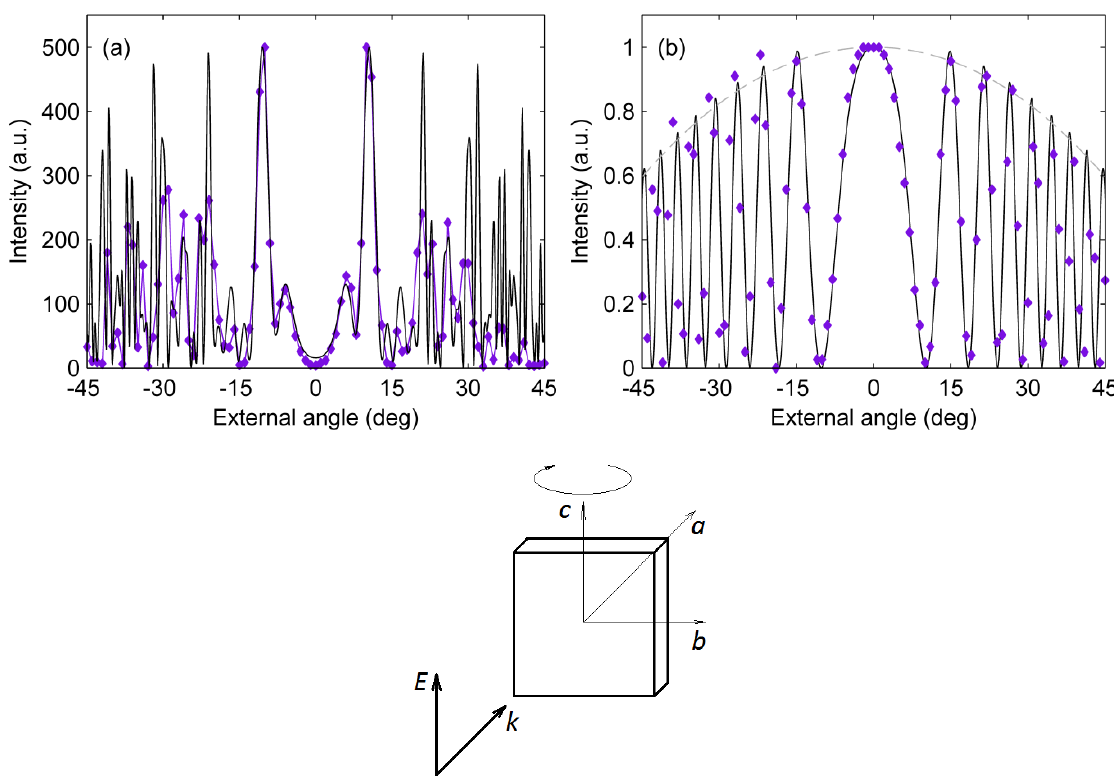
Figure 2. ( a ) Angular dependence of the second harmonic for nonlinear photonic crystals (NPC) and strontium tetraborate (SBO); ( b ) Maker fringes for single domain sample of SBO. Input radiation (532 nm) direction k , polarization of input radiation and second harmonic (266 nm) E .